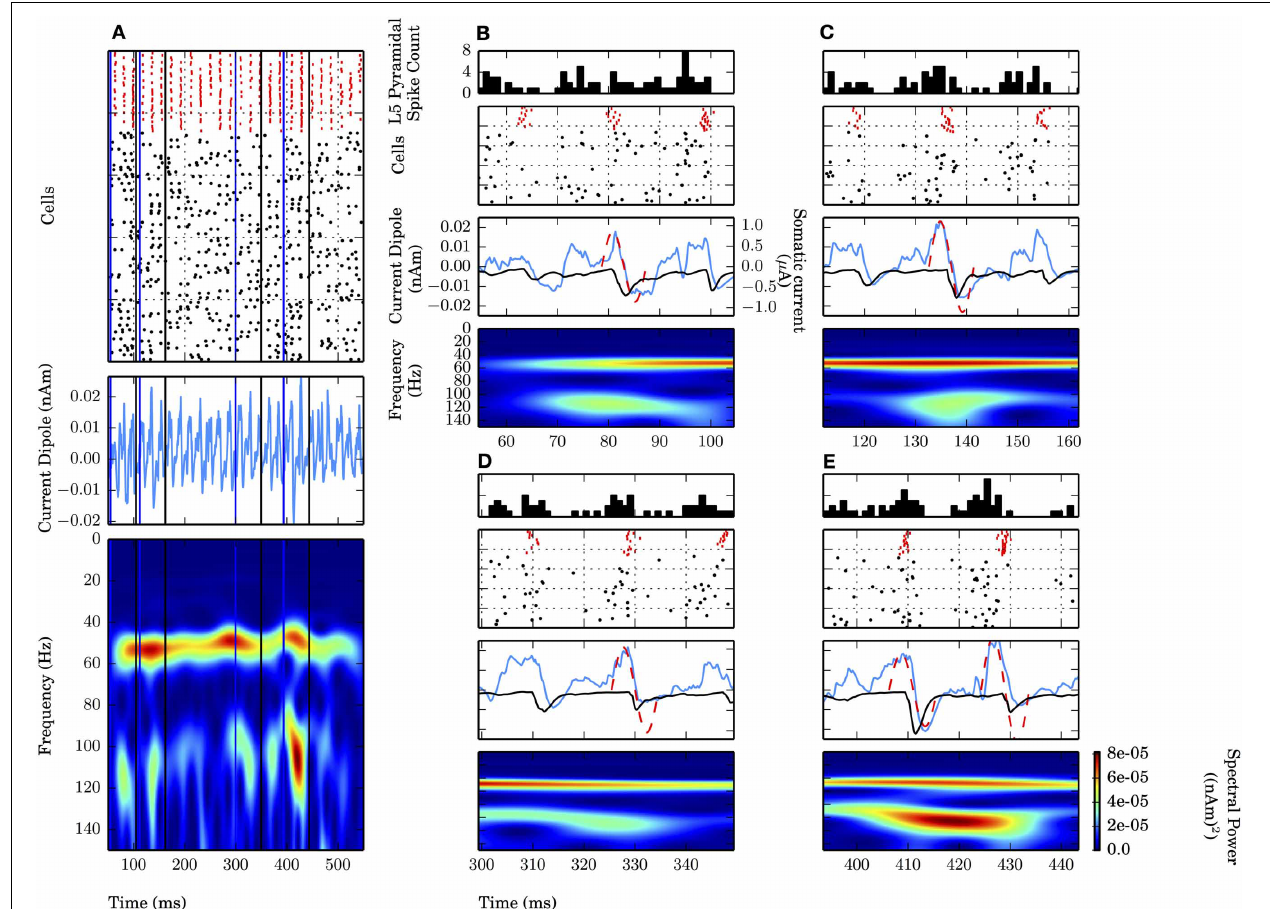
FIGURE 4 | High gamma frequency (100–120Hz) oscillations due to specific waveform not separate oscillatory process or uncorrelated spiking. Four epochs (B–E) of an example weak PING simulation (see text). Mean rate of E cell spikes in this example is 11 . 7 ± 2 . 8Hz. PSTH = 1ms. (A) Weak PING simulation, from top to bottom: spike (cid:2) t bin rastergram of 100 E cells (black) and 35 I cells (red); current dipole (nAm); Morlet spectrogram of current dipole. Weak PING oscillation at 52Hz (count 26 inhibition-mediated cycles in 500ms in raster), Morlet spectral power (P M ) of 7.69 × 10 − 5 (nAm) 2 at 54Hz in this band. Epochs of high gamma frequency activity denoted by lines for start times (blue) and end